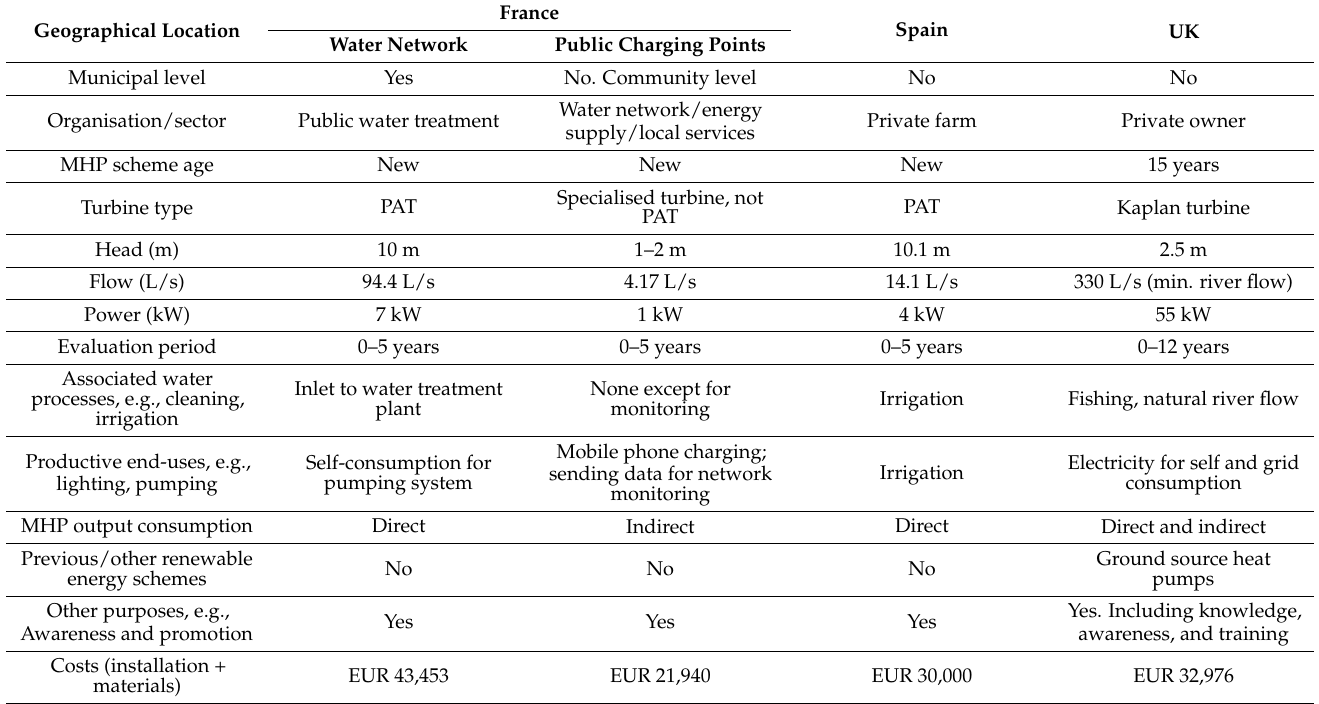
Table 2. Demonstrator sites in this